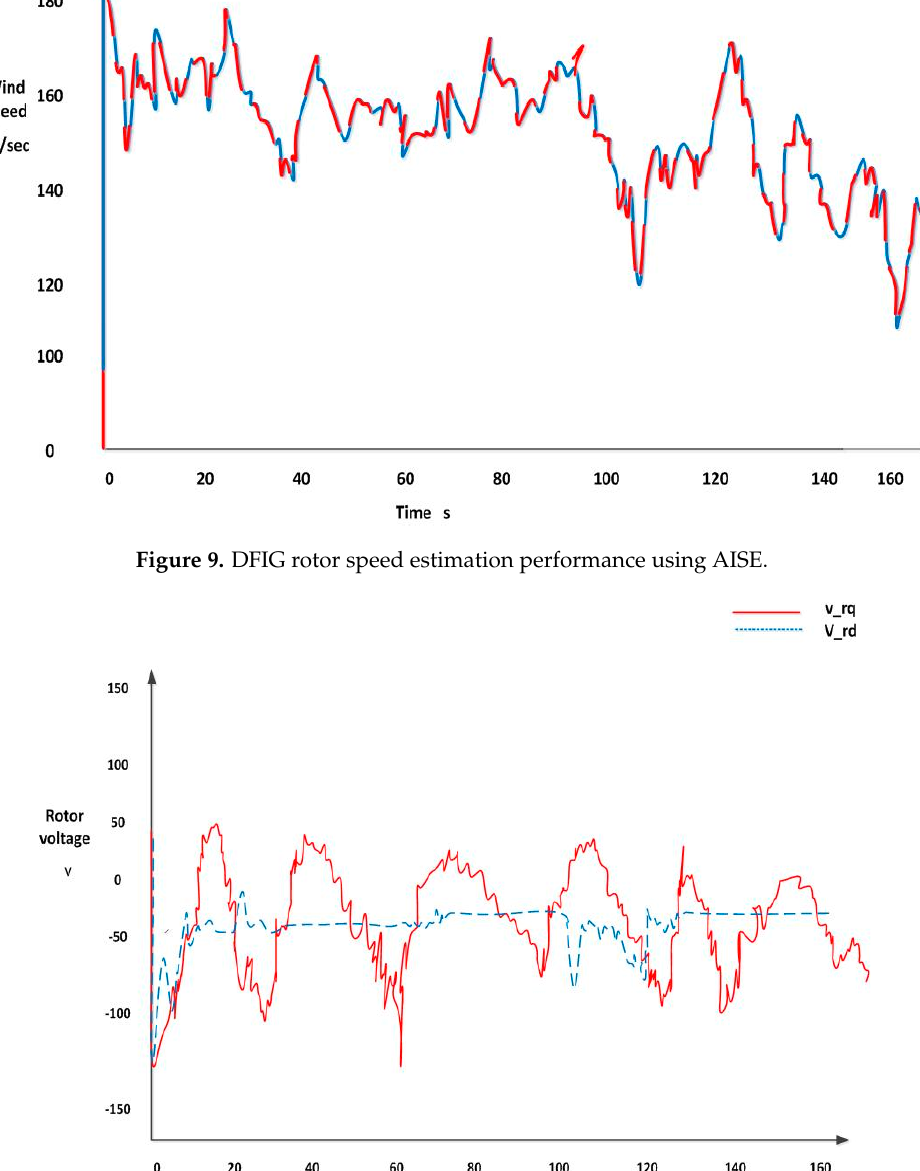
Figure 10. The DFIG rotor quadrature and direct voltages ( V rq and V rd ).